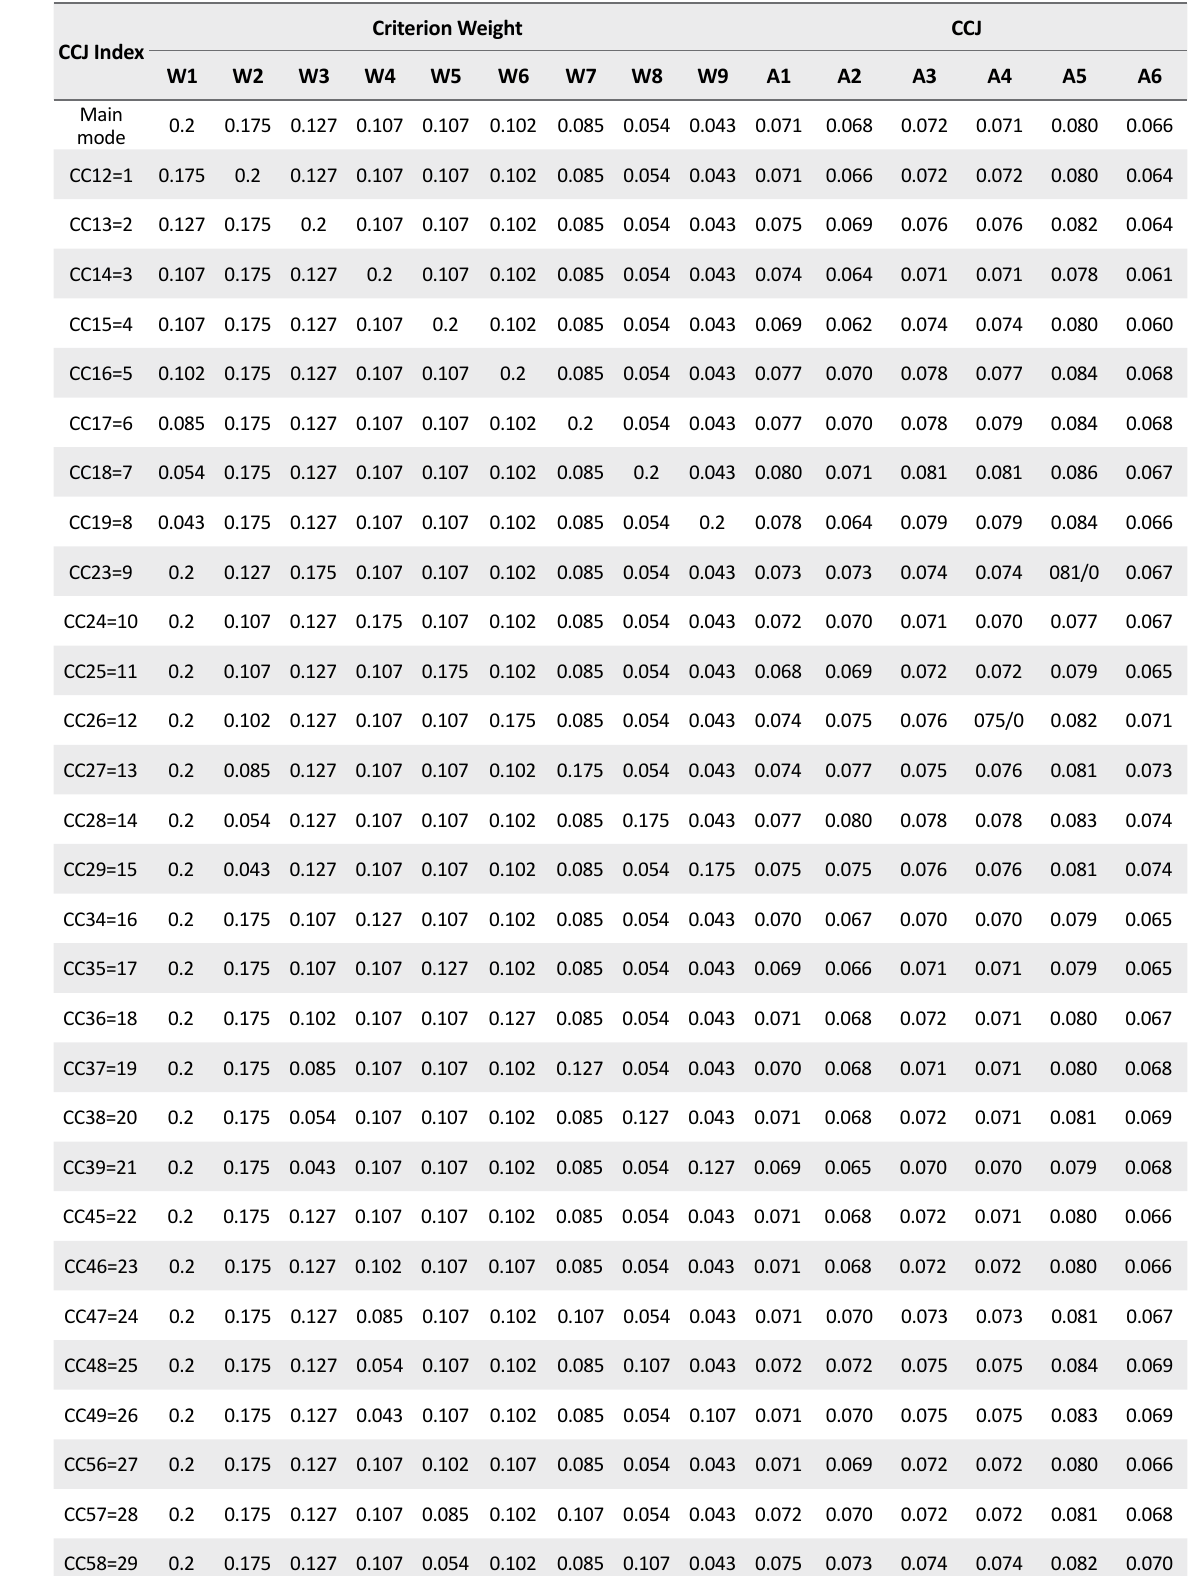
Table 14. CCJ index values (proximity coefficient) in the sensitivity analysis of alternatives for different weighting scenarios